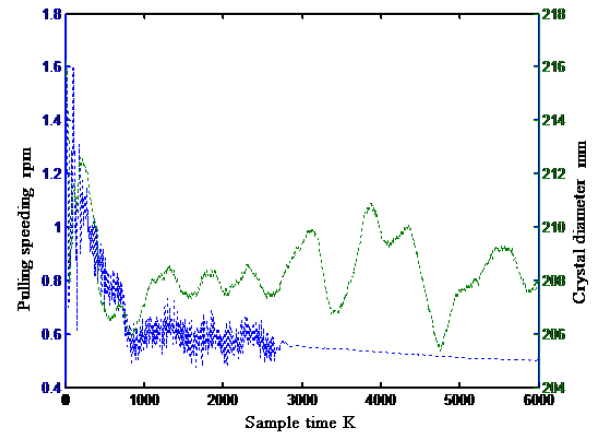
Figure 8. The curves of crystal diameter and pulling speed.